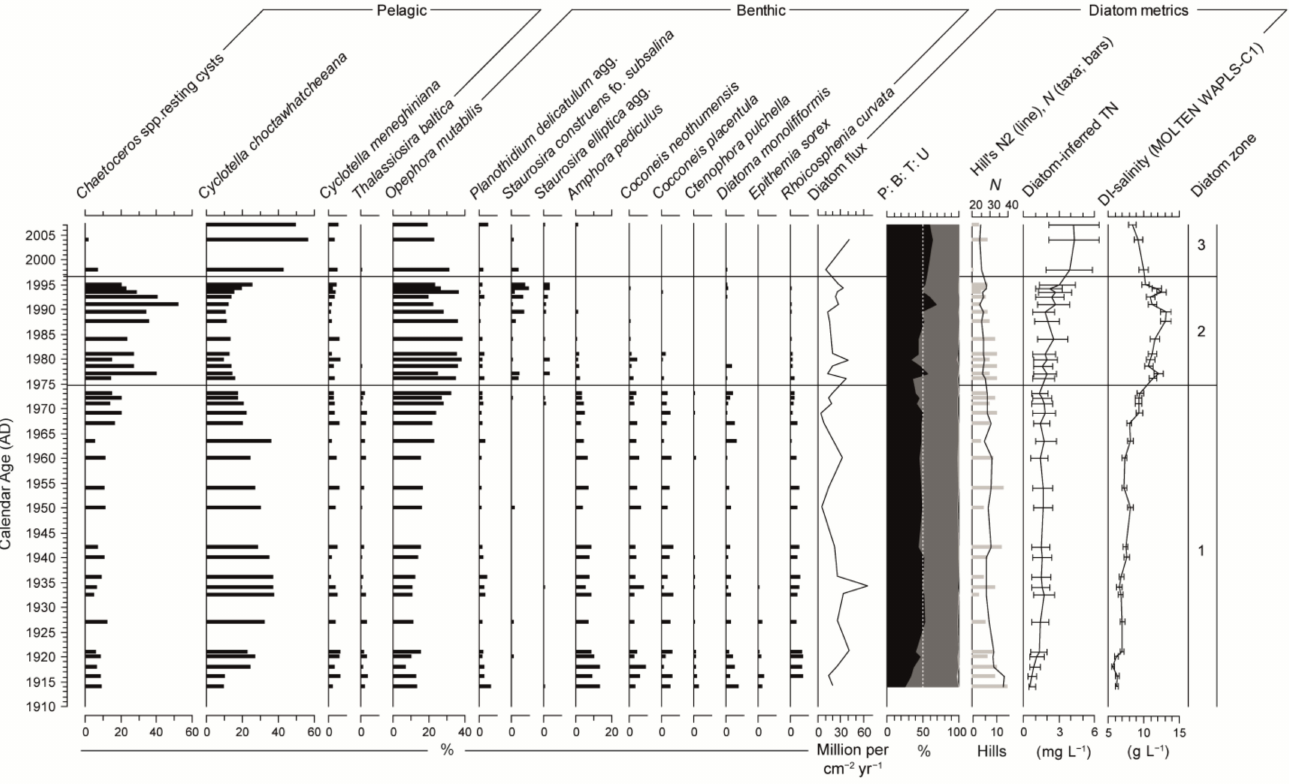
Figure 4. Kilen percentage diatom assemblage and associated metrics. Diatom-associated metrics include diatom flux based on the 210 Pb/ 137 Cs age–depth model; Pelagic: benthic: tychopelagic: undifferentiated (P:B:T:U) ratios; Hill’s N2 measure of diversity and number of taxa present ( N ), diatom-inferred total nitrogen (DI-TN) based on the MOLTEN Western Baltic dataset [56] and diatom- inferred salinity based on a MOLTEN- and DEFINE-derived salinity dataset